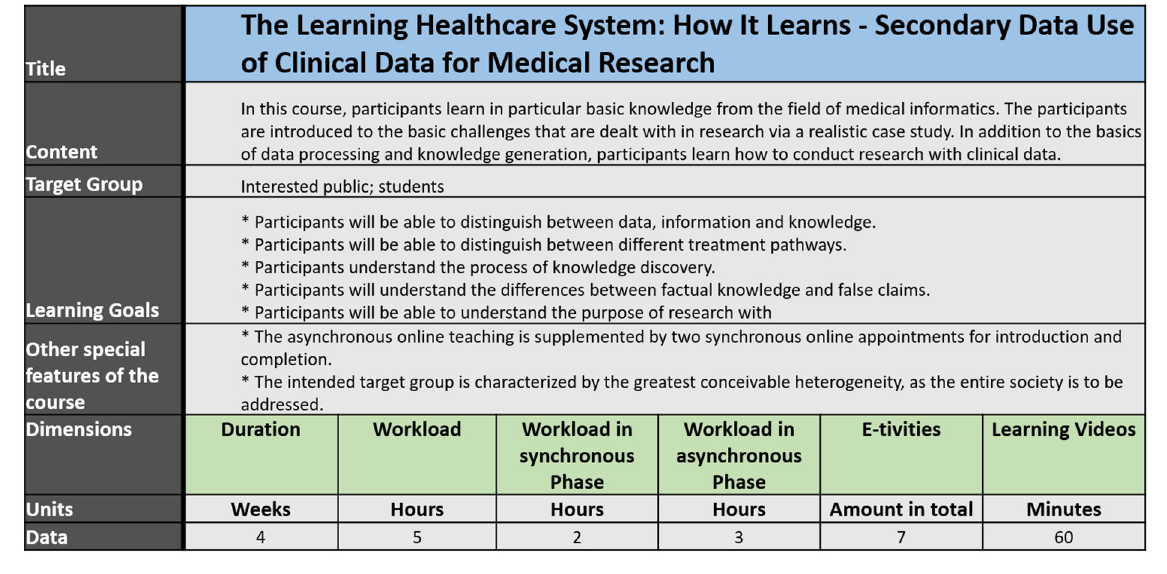
Figure 4. Course properties for ZLG-TP1 Course: “The Learning Healthcare System: How It Learns—Secondary Data Use of Clinical Data for Medical Research”.